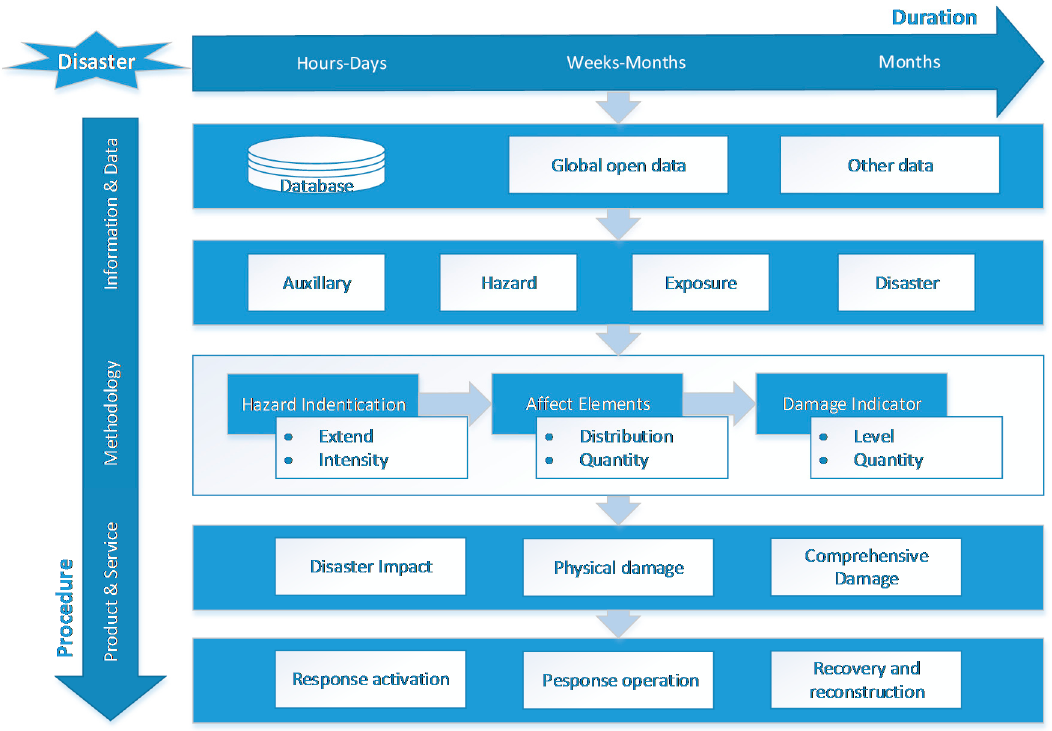
Figure 1. Geo-information Integration Framework for Disaster Assessment.